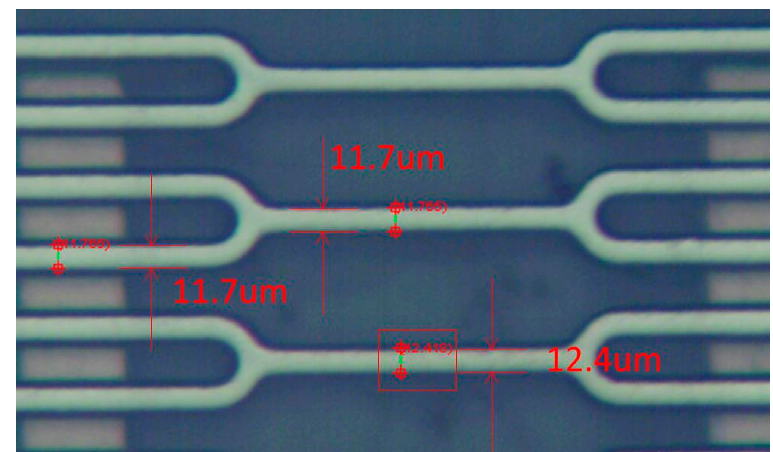
Figure 13. The line width of the suspended spring measured by microscope.